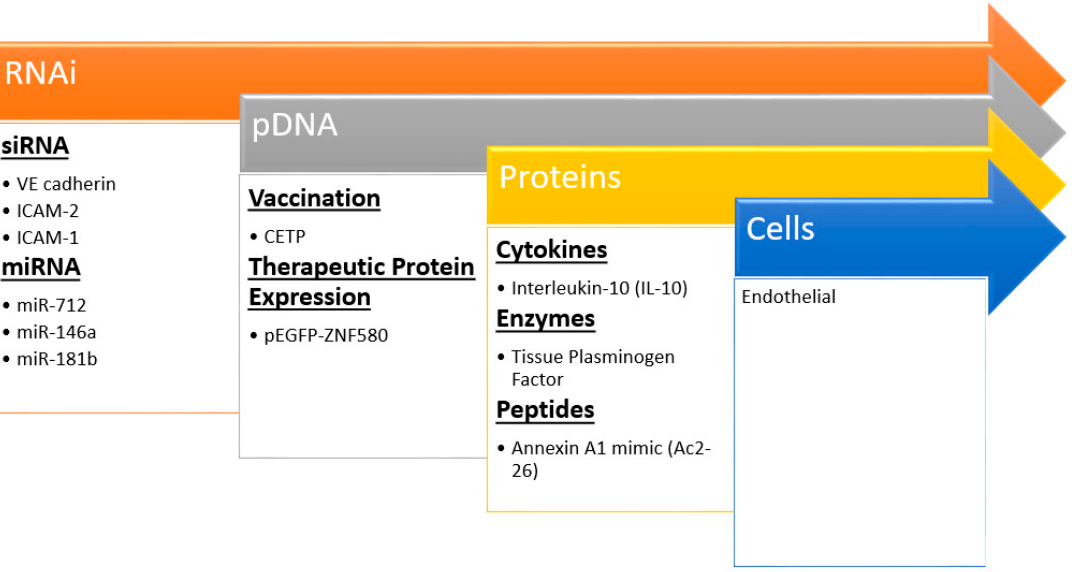
Figure 4. Recent examples of nanoparticle biotherapeutics and their targets in preventing atherosclerosis. Insights and techniques gained from siRNA studies has led to the delivery of larger and more complex molecules even up to cells.